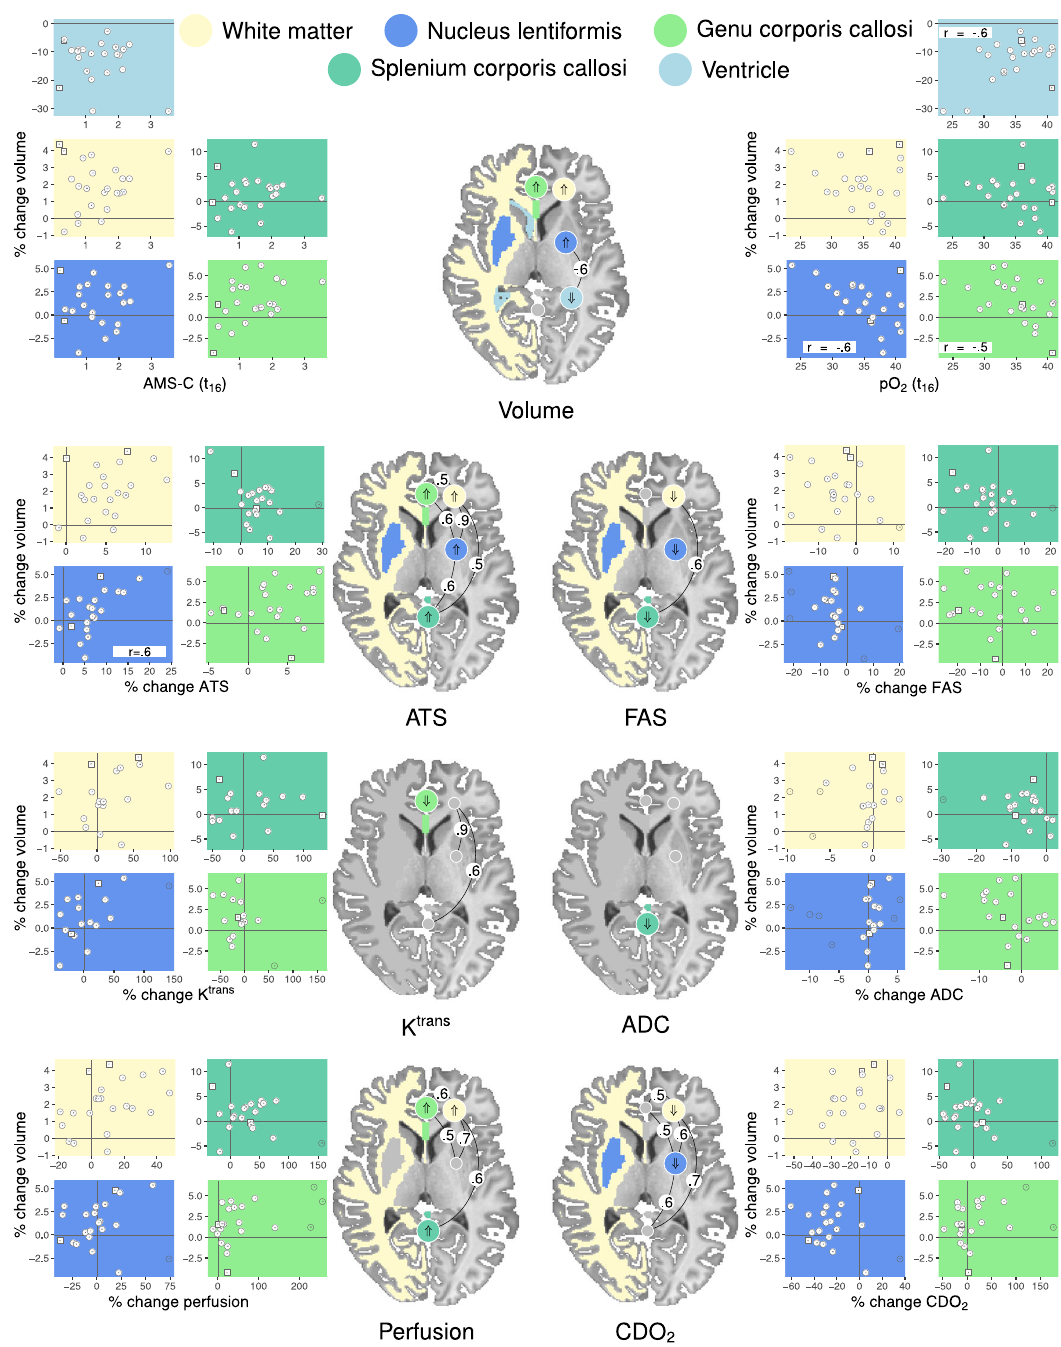
Fig. 4 Hypoxia-induced regional, normalized changes in the brain after 16 h of hypoxic exposure. Changes of brain volume, average tissue sodium (ATS) and fl uid-attenuated sodium (FAS) signals, the transfer constant K trans , apparent diffusion coef fi cient (ADC), perfusion, and cerebral oxygen delivery (CDO 2 ) values as well as altitude mountain sickness (AMS) scores are shown. For each measure, colored region of interest (ROI) overlays in the right hemispheres (radiologic convention) indicate changes after hypoxic exposure, the correspondingly colored circles in the left hemisphere indicate the direction of the change. Gray ROI overlays and small gray circles represent ROIs without signi fi cant change after hypoxic exposure in the respective signal. Signi fi cant correlations between ROIs are projected onto the left hemisphere of the brain (black arrows, white markers). Insets at the sides show normalized changes in each measure (x-axis) plotted against normalized changes in volume for reference. ROIs are color-coded. Correlation coef fi cients are reported only if these were signi fi cant. Filled circles represent data points included into the statistical analysis; open circles represent outliers excluded from the